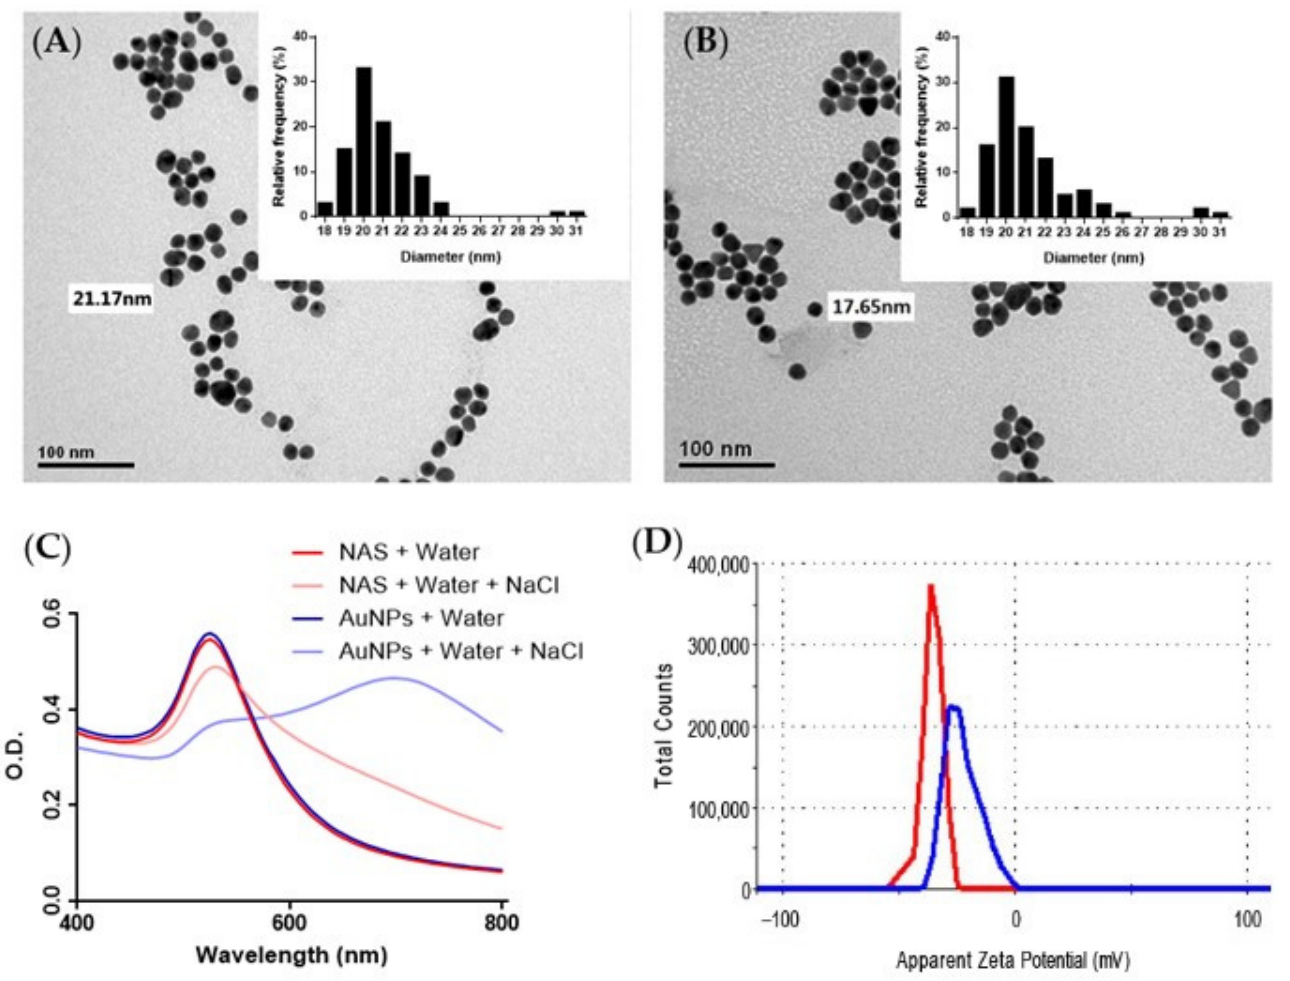
Figure 2. TEM micrographs of ( A ) AuNPs and ( B ) NAS, showing the average diameters and particle size distribution (histograms insets). Characterization of the nanoparticles is presented in terms of ( C ) zeta potential of AuNPs (blue line) and NAS (red line), and ( D ) absorption spectra in the visible range for AuNPs and NAS upon NaCl addition.